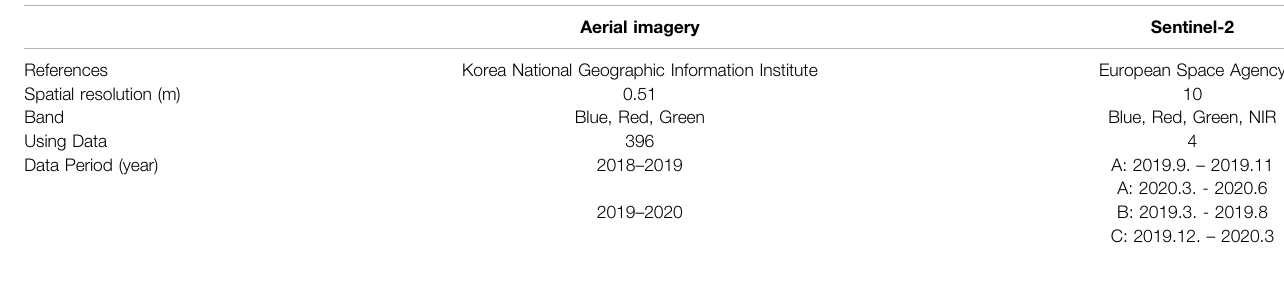
TABLE 1 | Original aerial and satellite image acquisition